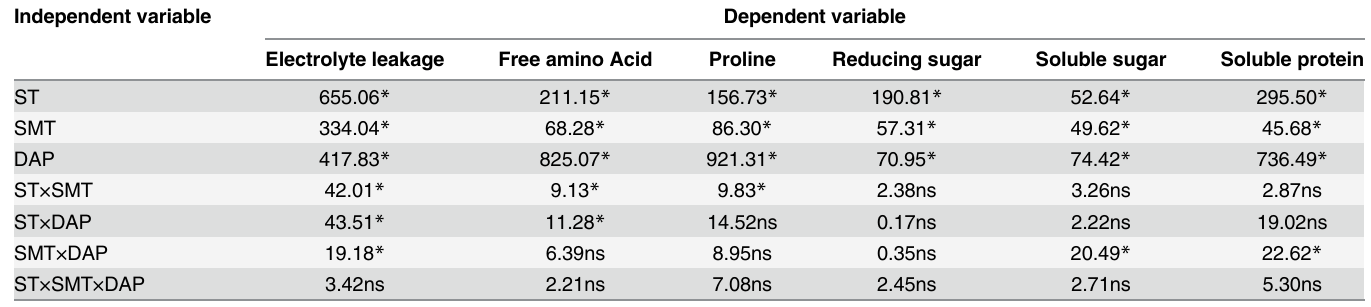
Table 6. Results of variance analysis of ST, SMT, DAP, and their interactions for free amino acid pool, proline, plasma membrane permeability, reducing sugar, soluble sugar, and soluble protein activities.a Independent